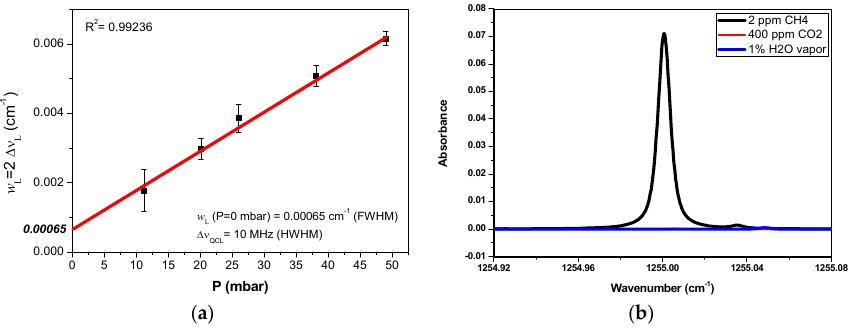
Figure 2. ( a ): Plot of CH 4 absorption line width vs. pressure for determination of the DFB ‐ QCL emission line width; ( b ): Simulation of 2 ppm CH 4 absorption spectrum around 1225 cm − 1 at 40 mbar in a multipass cell with 175 m effective optical path ‐ length.